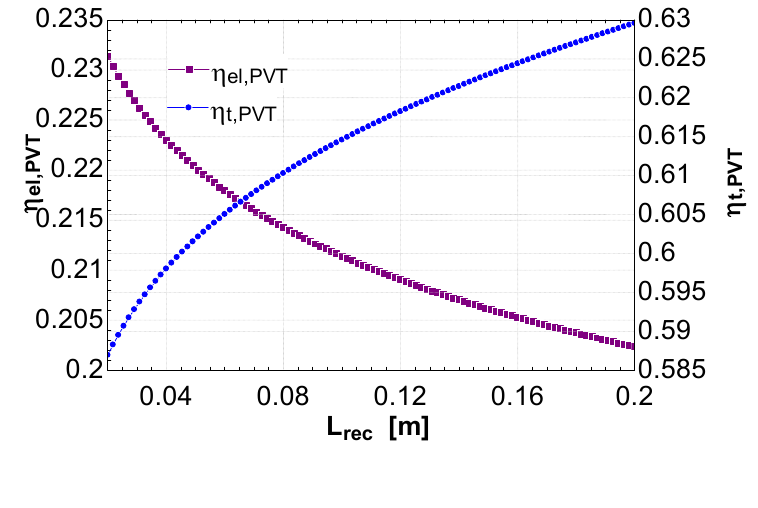
Figure 9. CPVT thermal and electrical efficiency vs. receiver